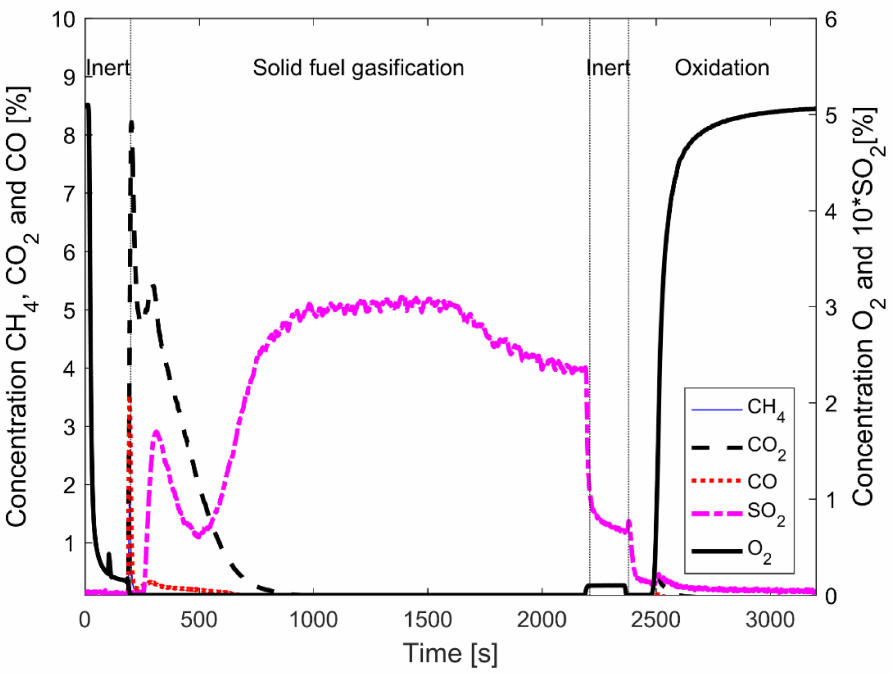
Figure 5. One cycle at 870 ◦ C of char gasification using LD slag as bed material in the laboratory scale fluidized bed with 0.4% SO 2 present in the fluidization